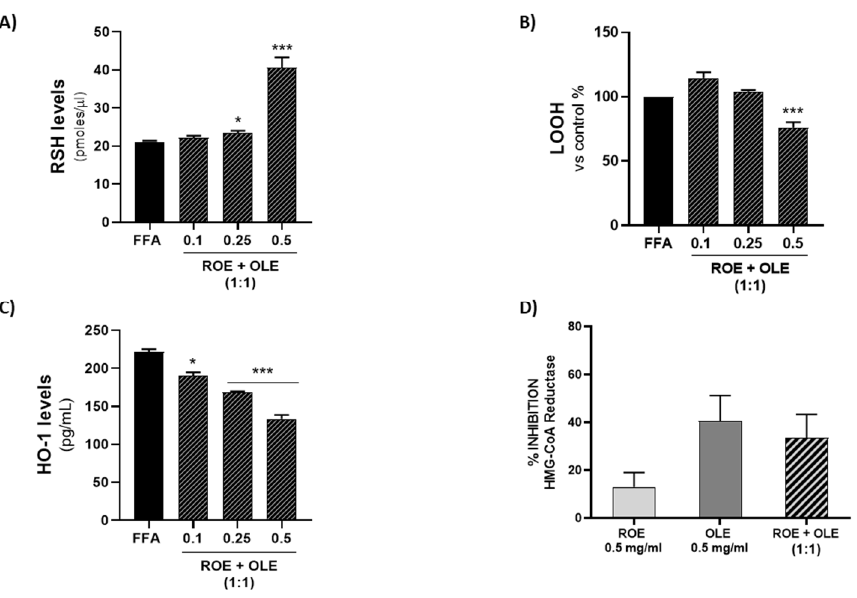
Figure 6. Evaluation after 72 h of different 1:1 combination of ROE and OLE effect on ( A ) RSH levels; ( B ) LOOH; ( C ) HO-1 levels. Significant vs FFA: * p < 0.05; *** p < 0.0005. ( D ) Measurement of HMG-CoA reductase inhibiting activity of ROE and OLE (0.5 mg/mL) and 1:1 combination of them. Results are expressed as mean ± SEM.